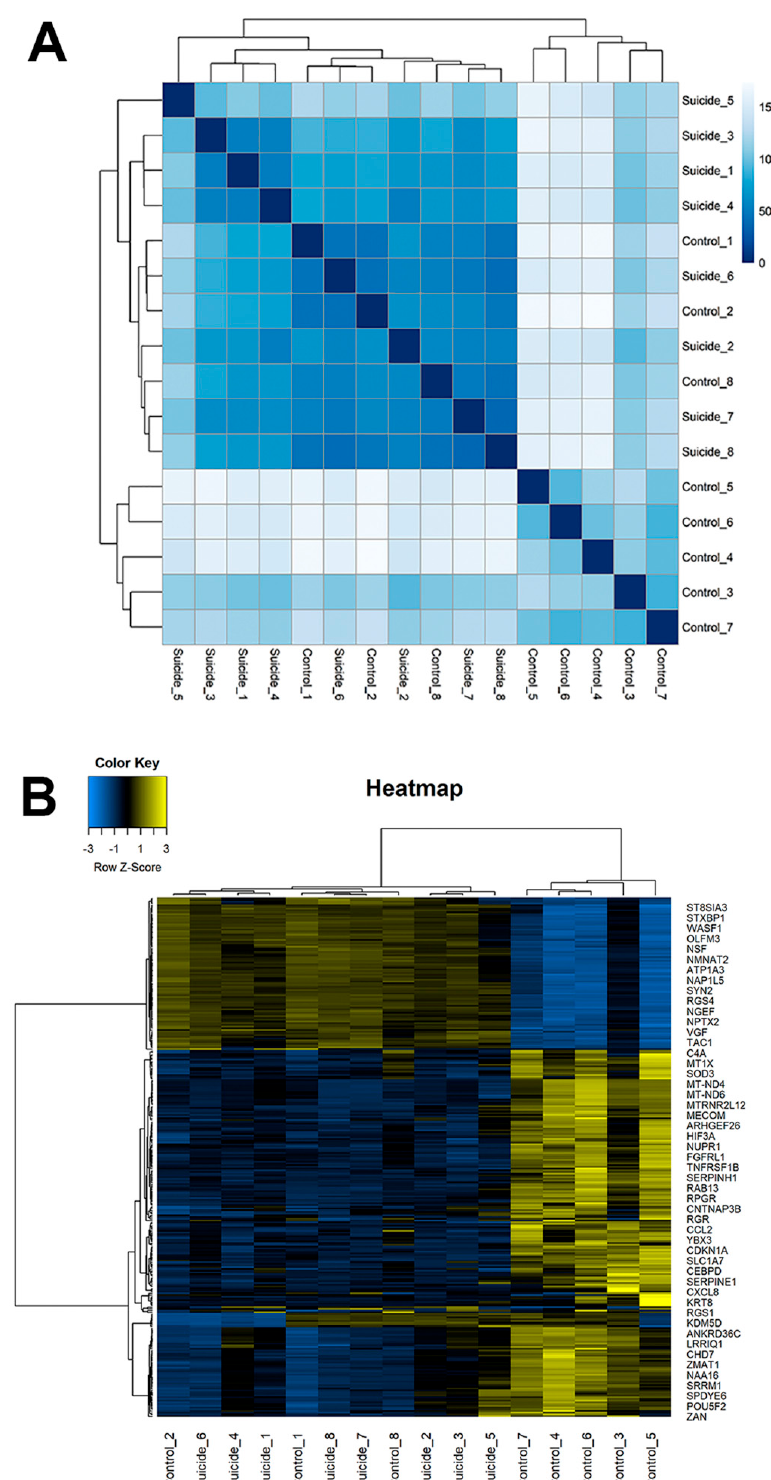
Figure 1. Analysis of gene expression between suicide and control groups. ( A ) Hierarchical clustering of 16 RNA-seq samples based on the Euclidean distance. A heatmap of the distance matrix shows